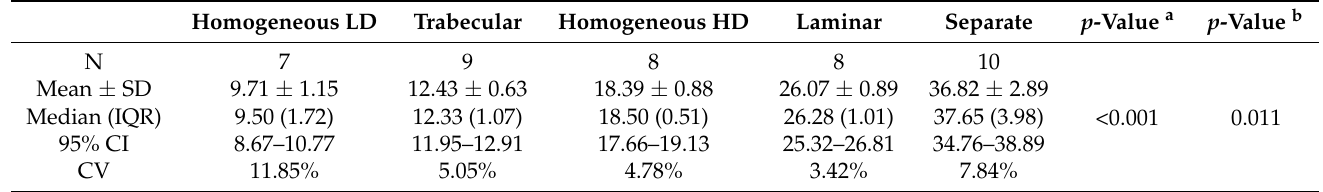
Figure 4. The distribution of MHD across five types of CSDHs based on internal structure. A sig- nificant difference was found using Dunn’s post -hoc test after a Kruskal – Wallis test. a p < 0.05 compared to LD; b p < 0.05 compared to trabecular; c p < 0.05 compared to HD. Note: Values more than three IQRs from the end of a box are labeled as extreme, denoted with an asterisk (*). Values more than 1.5 IQRs but less than 3 IQRs from the end of the box are labeled as outliers (o). Table 2. The relationship between MHD and the type of CSDHs based on internal structure (five-type classification).